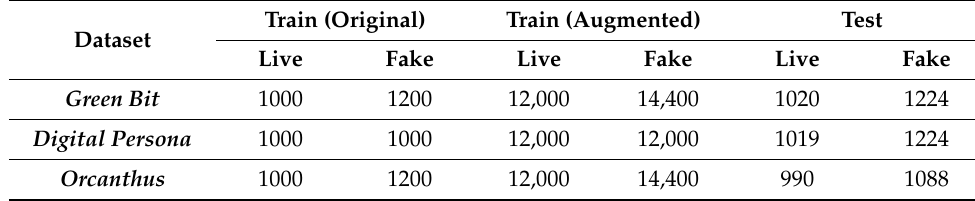
Table 1. The dataset structure for